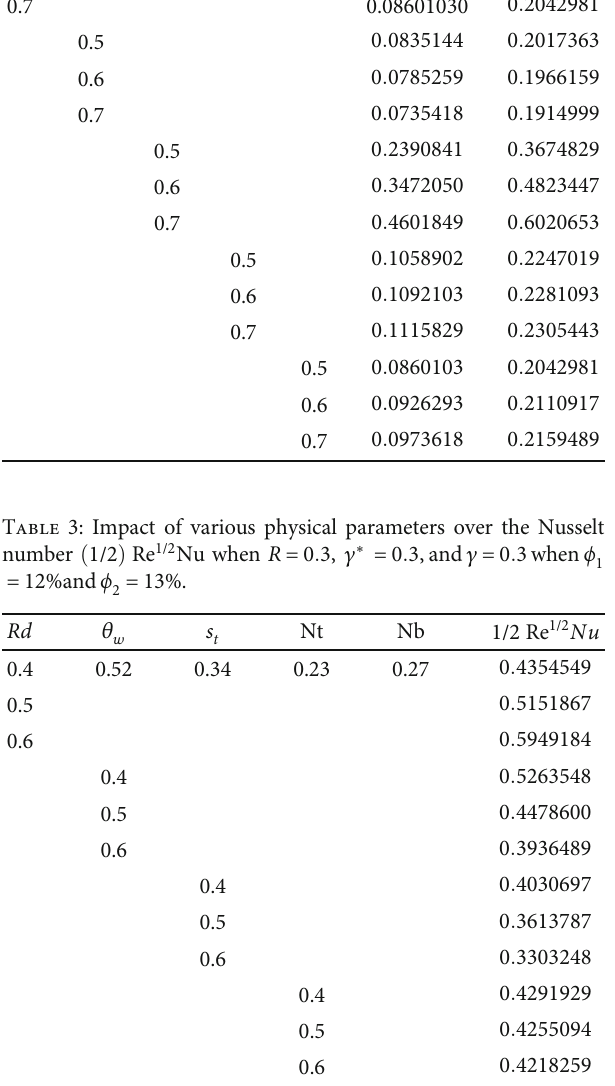
= 0 : 4, s = 0 : 7, γ ∗ w t